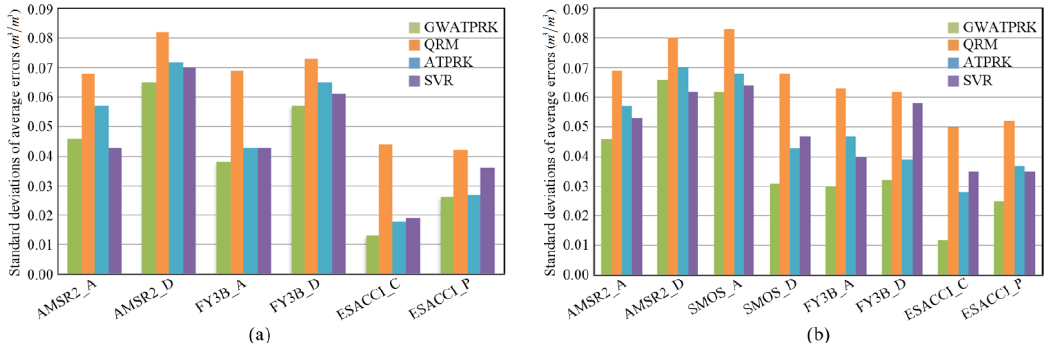
Figure 10. Standard deviations of average errors of 1 km predictions from different coarse SSM products in two experimental regions: ( a ) upper HBR area and ( b ) Naqu area.